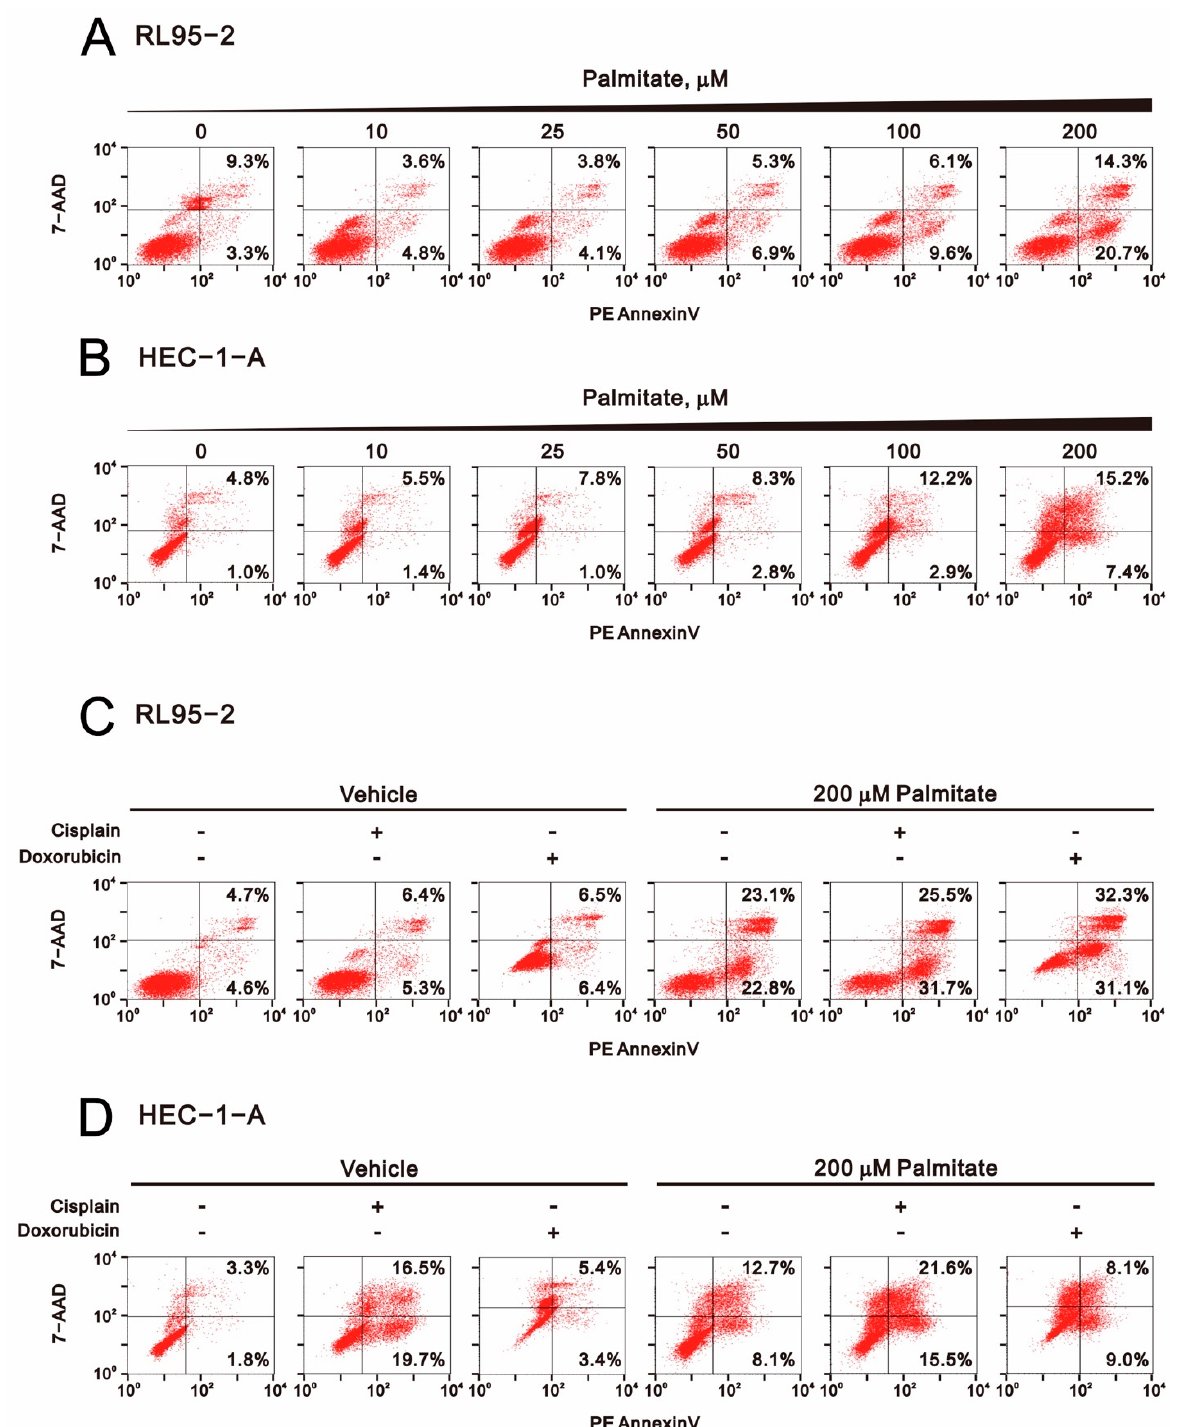
Figure 6. Effect of palmitate alone and in combination with cisplatin or doxorubicin on apoptosis among human endometrial cancer cells. ( A ) RL95-2 and ( B ) HEC-1-A cells were incubated for 24 h, after which they were treated for 24 or 48 h with palmitate (0, 10, 25, 50, 100, 200 µ M). ( C ) RL95-2 cells treated for 24 h with 5 µ M cisplatin or 0.5 µ M doxorubicin plus 200 µ M palmitate. ( D ) HEC-1-A cells treated for 48 h with 50 µ M cisplatin or 0.5 µ M doxorubicin plus 200 µ M palmitate. Apoptosis markers labeled by PE-Annexin V and 7-AAD were analyzed using flow cytometry.